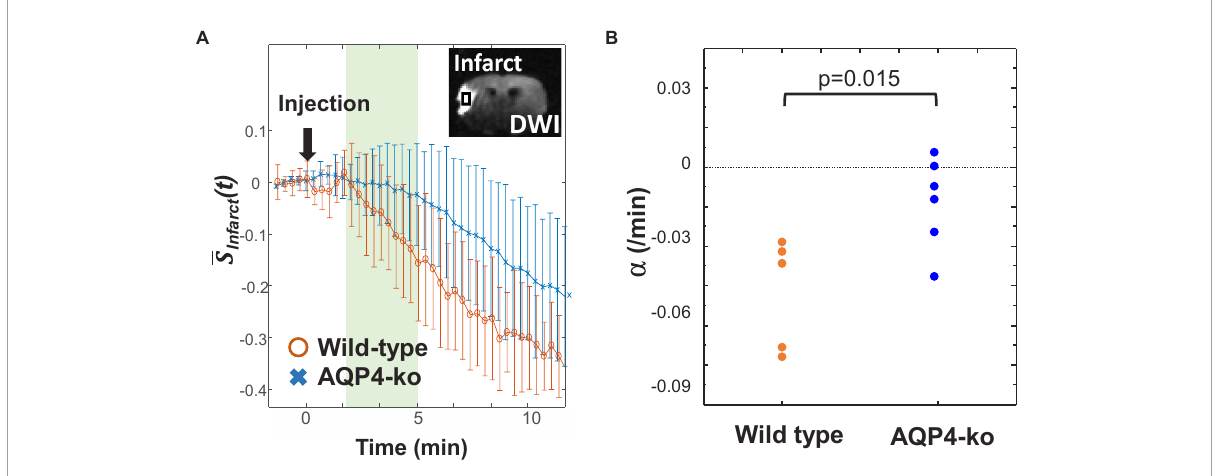
FIGURE4 Signal attenuation in the infarct region. (A) Standardized proton-density-weighted imaging (PDWI) signal in the infarct region of the wild-type (orange) and AQP4 knockout (AQP4-ko) (blue) mice. The slope α is calculated from the signal recorded at 3–5 min after deuterium-labeled water (D 2 O) injection. (B) The estimates of α for the two groups were compared using an unpaired t -test and the p value is shown at the top of the